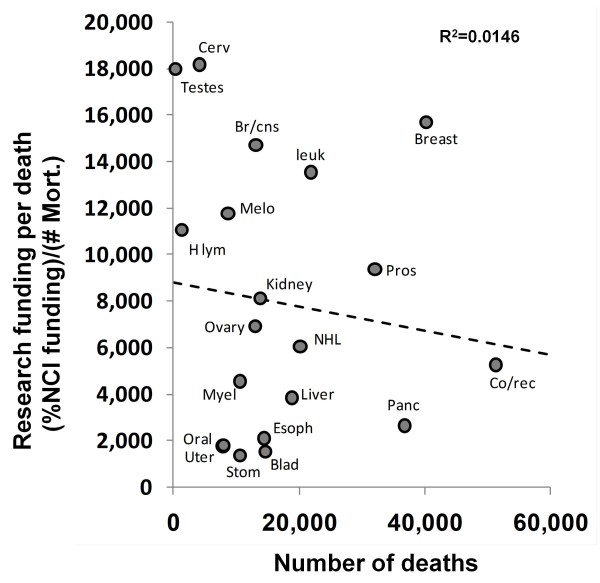
NCI research funding relative to total number of deaths. Dashed line indicates linear regression and the R2 of 0.0146 indicates virtually no relationship between the number of deaths due to each cancer and the funding per death. Due to its extremely large number of deaths (approx. 160,000) and relatively low funding (approx. $1800 per death), lung cancer is excluded from this plot. Removal of the extreme value for testes cancer from this plot reverses the relationship (positive slope, R2 = 0.008), but it remains non-significant.